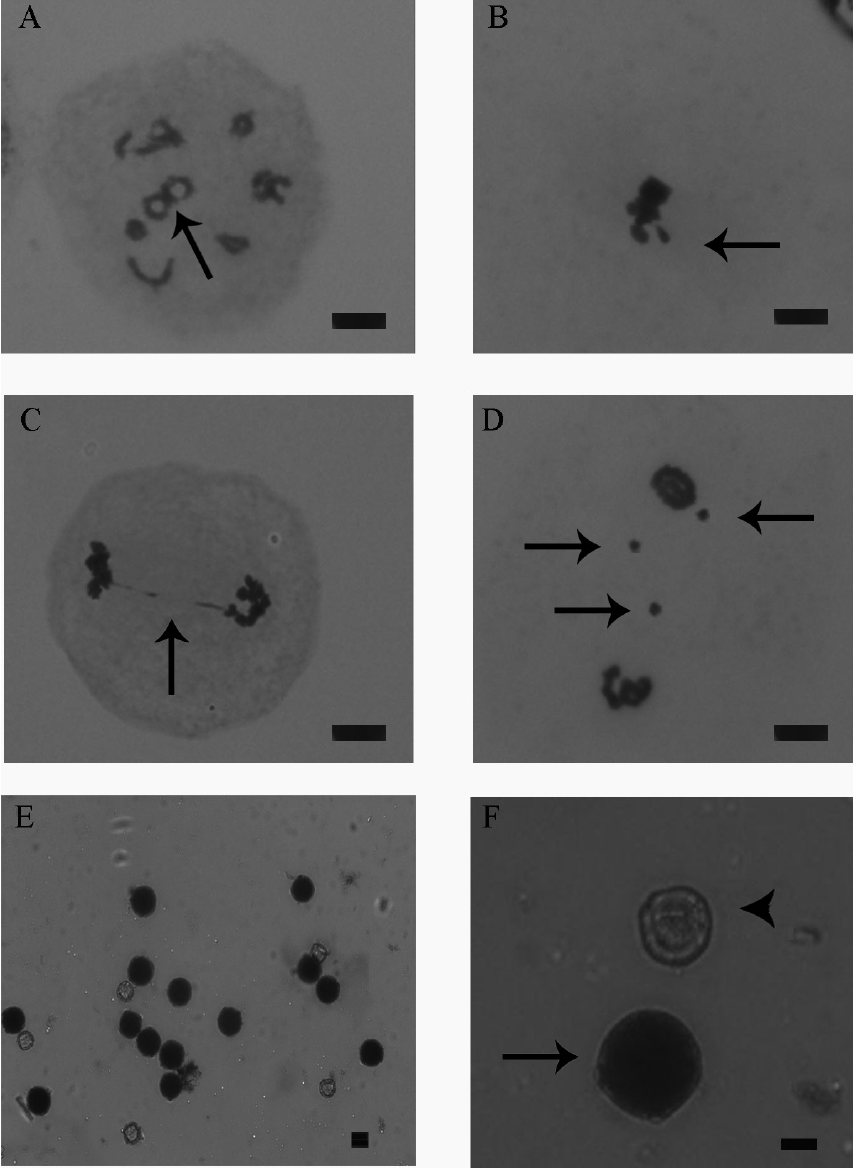
Fig. 2 – (A) Diakinesis with translocation (arrow), (B) Metaphase I with early segregaton (arrow), (C) Anaphase I with chromosome bridge (arrow), (D) Anaphase I with laggard chromosomes (arrows), (E) Pollen staining with Alexander solution, (F) Alexander staining: viable pollen (arrow) and non-viable pollen (arrow head). Barr = 5 μ